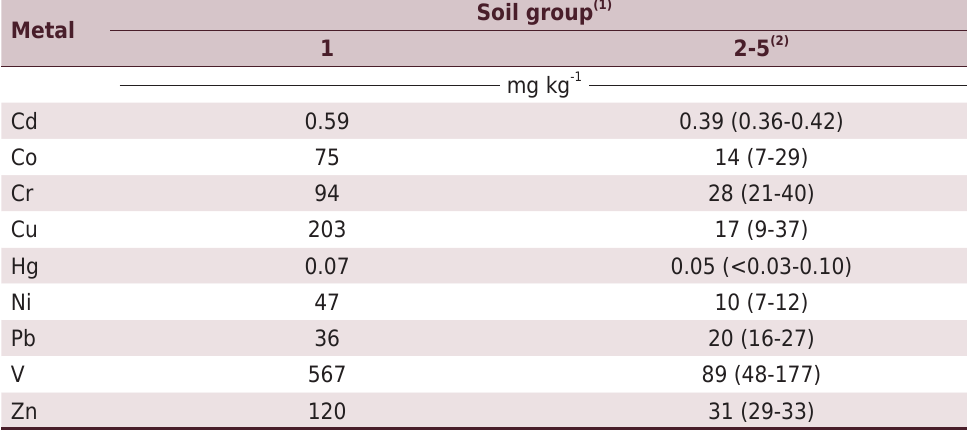
Table 7. Average quality reference values (QRVs) for metals, in the 90th percentile, by soil groups for the natural metals contents in soils of the state of Rio Grande do Sul